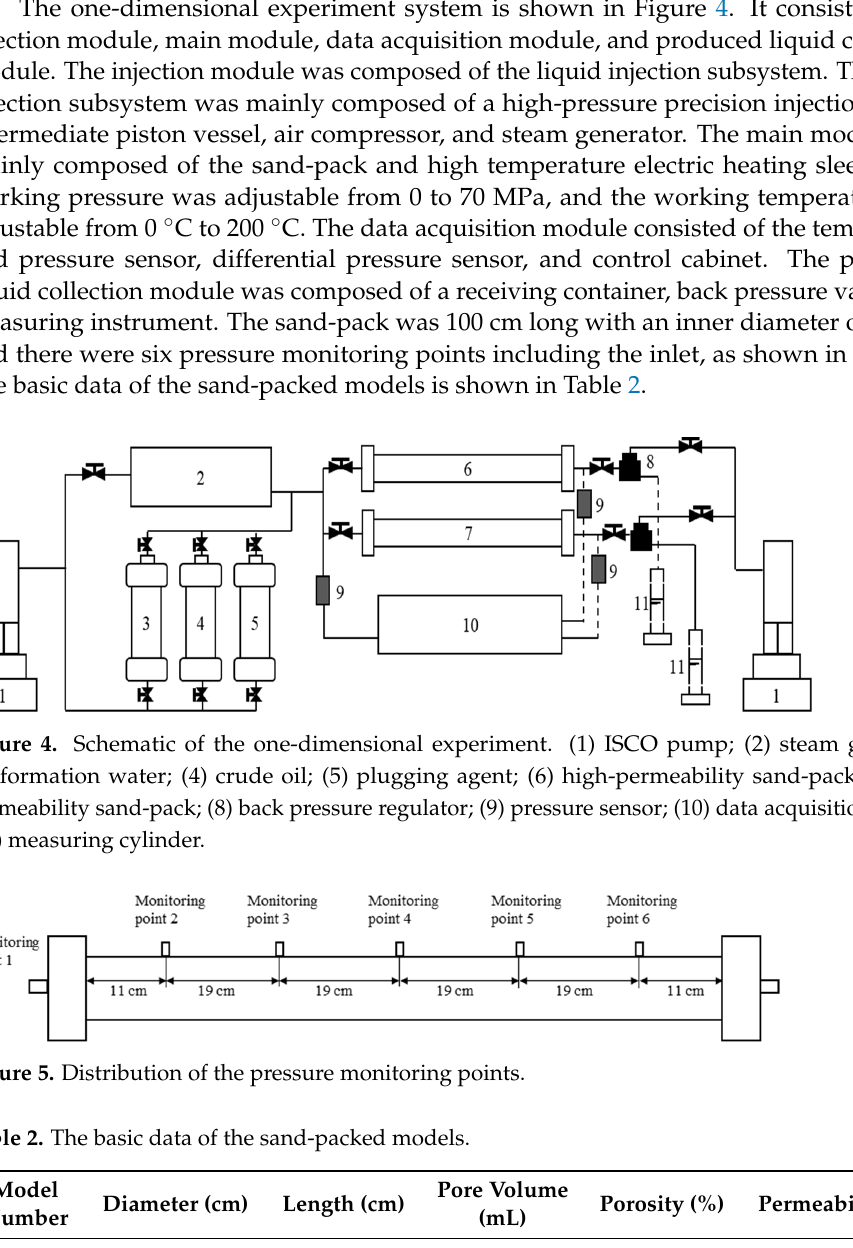
Table 1. Composition and content of the fly ash.